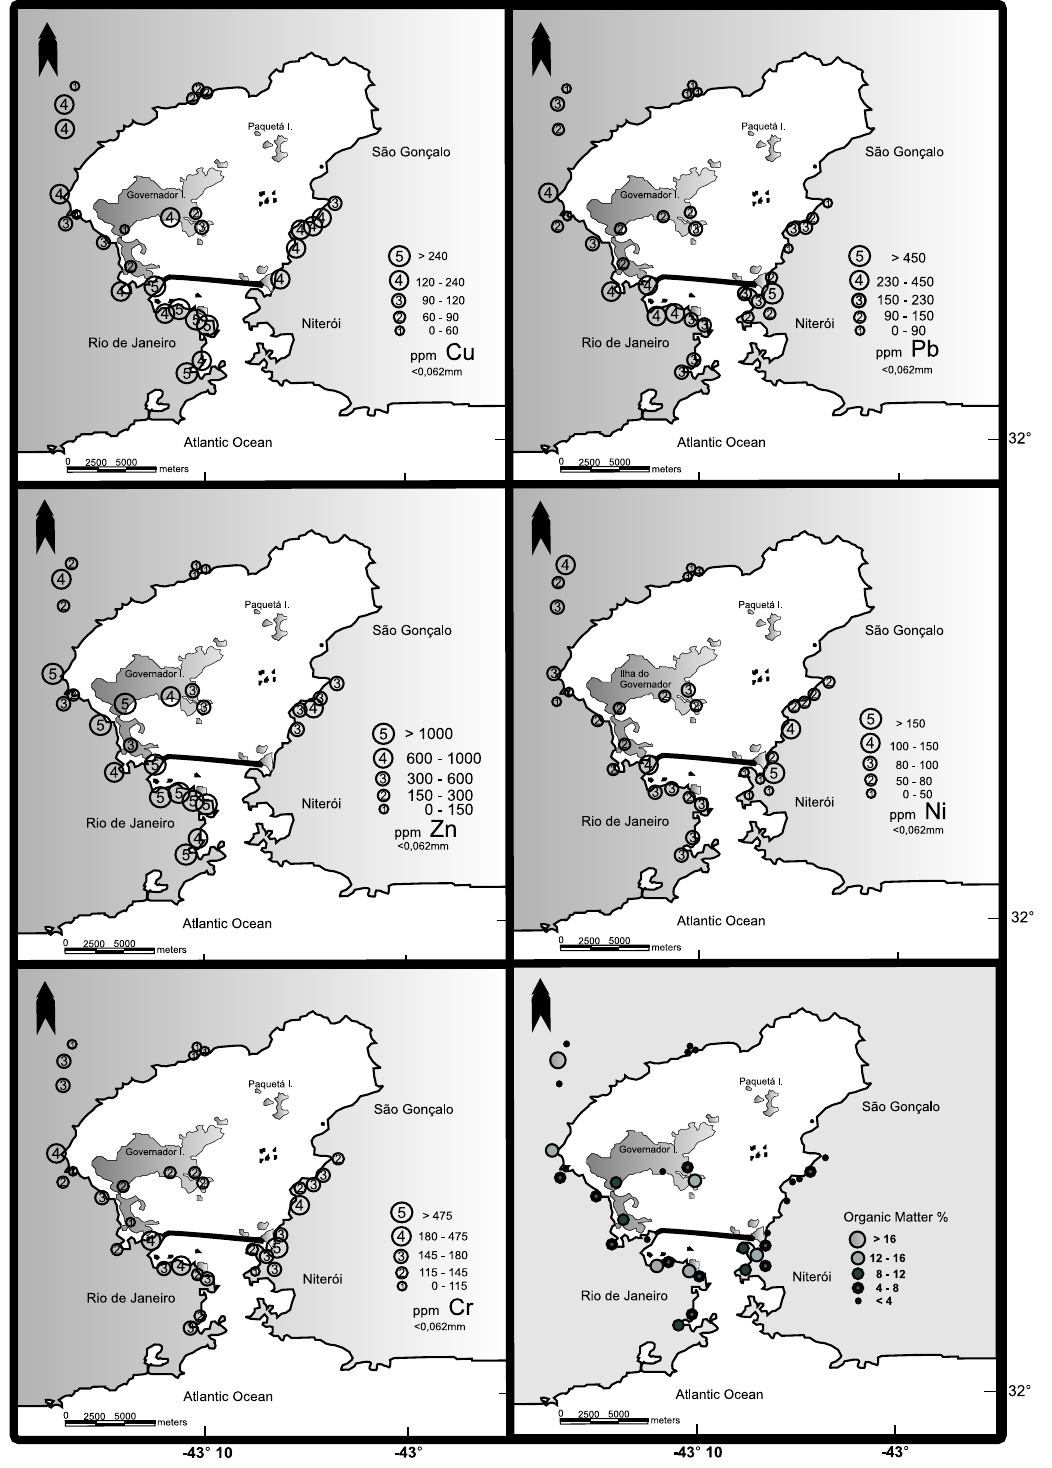
Fig. 3 – Distribution of Zn, Cu, Ni, Pb and Cr concentration in the urban street sediments around Guanabara